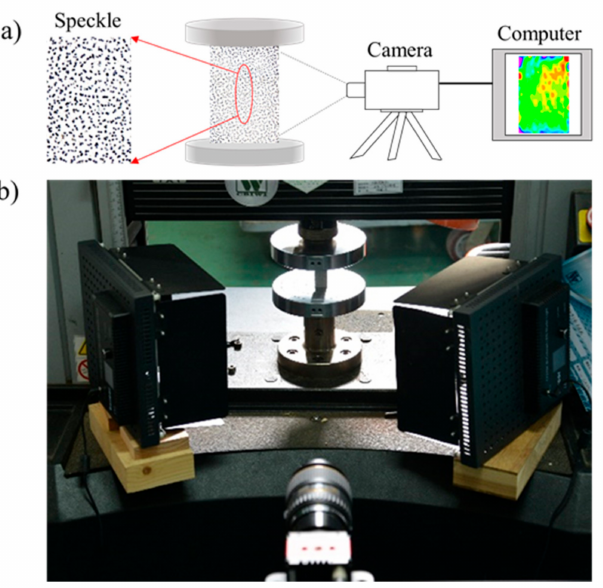
Figure 2. Schematic drawing of compression testing: ( a ) speckle on the specimen’s surface; ( b ) test